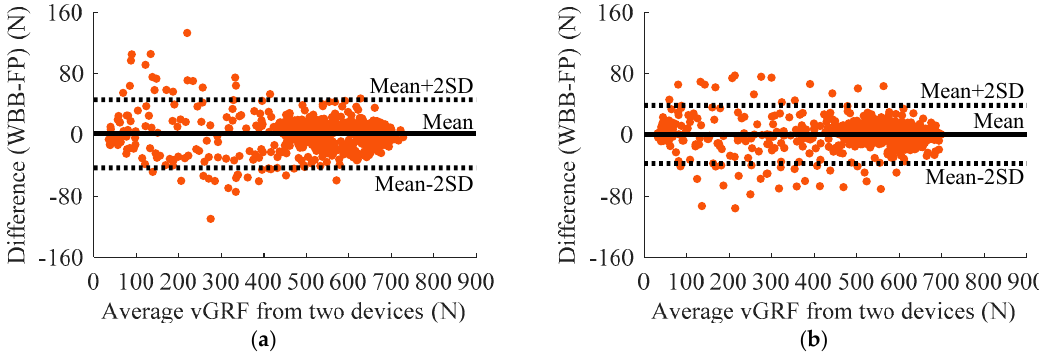
Figure 4. Bland–Altman plots showing the comparison between the force plates and the Nintendo Wii Balance Board (WBB). ( a ) Data from 10 steps walking straight (right foot—RF). ( b ) Data from 10 steps walking clockwise (CW) along the curved path (RF (IN—inside foot turning)).